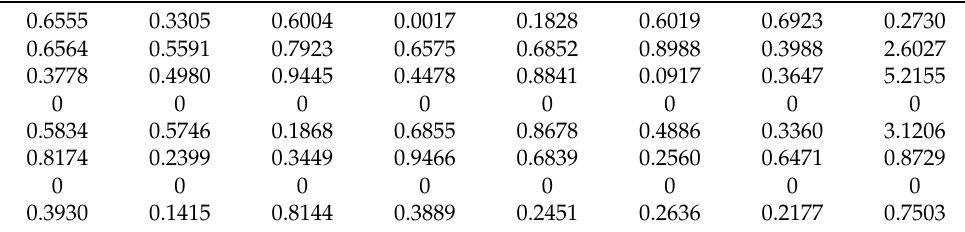
Table 4. Optimized weights for Type 1 failure for the GA method.